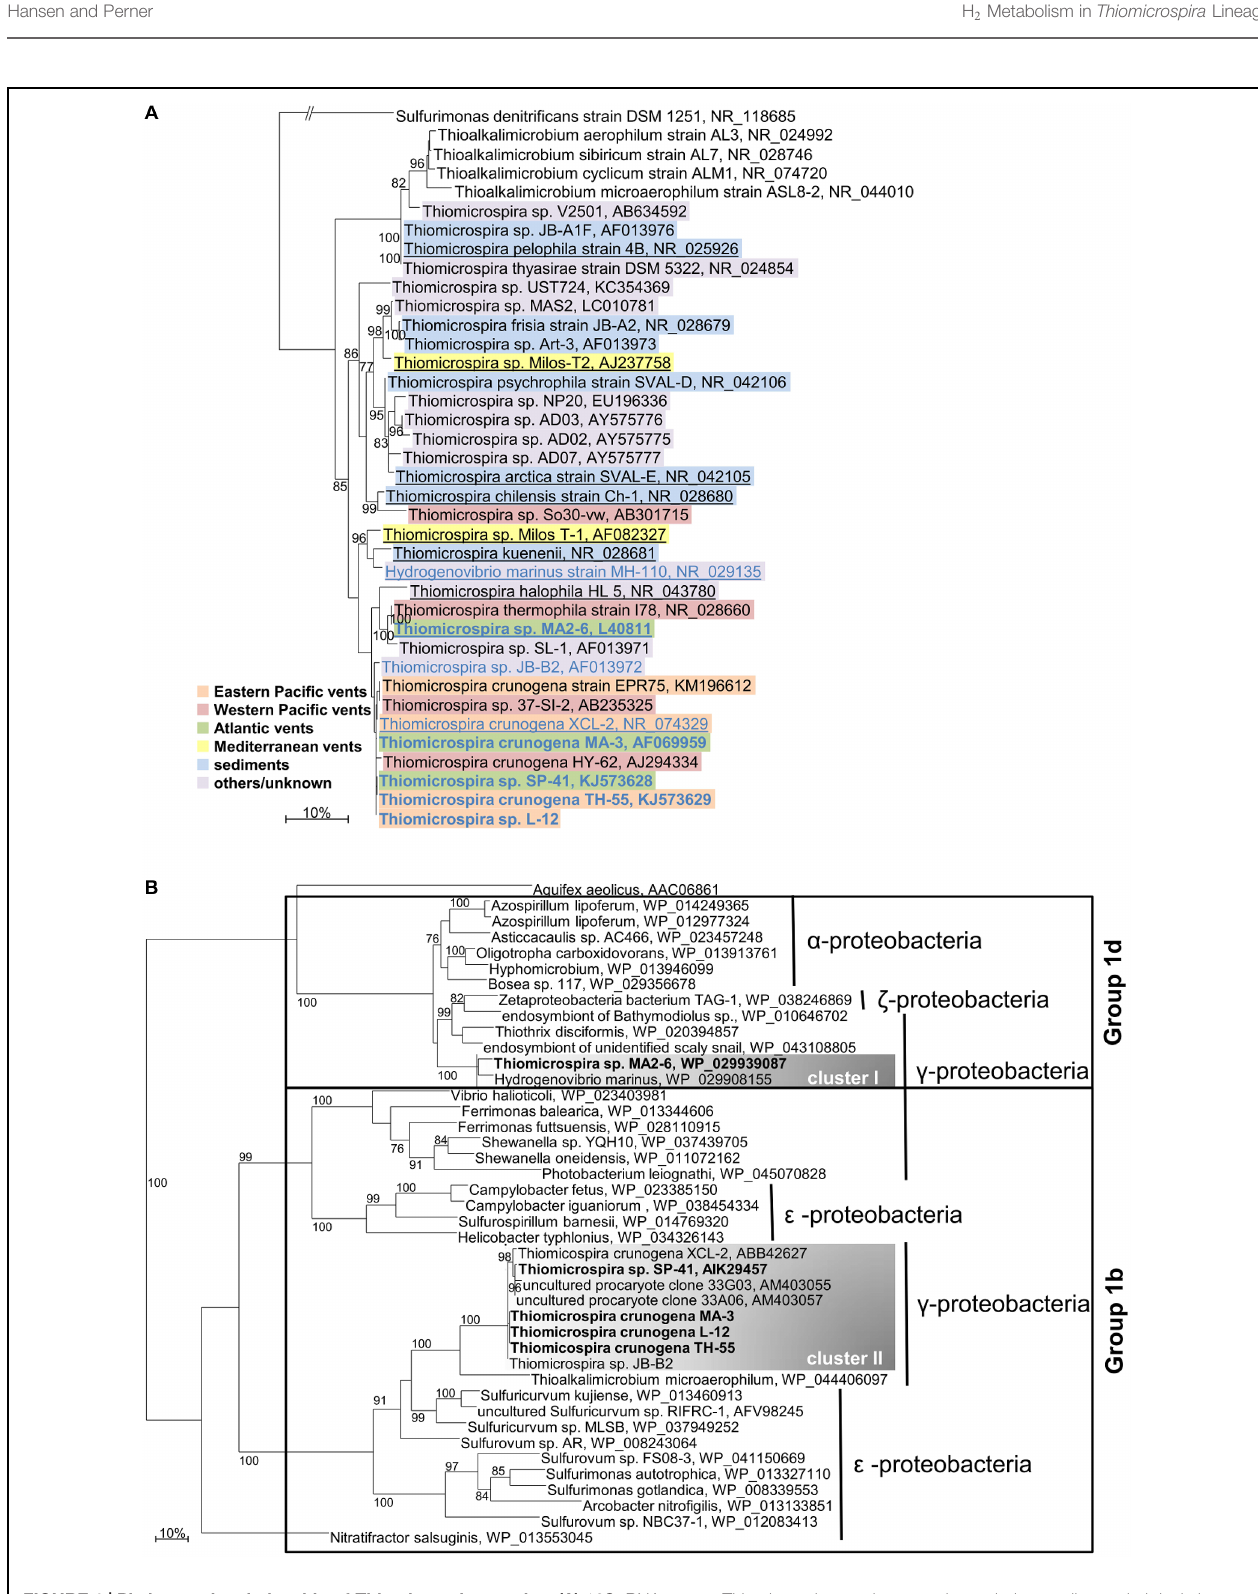
Frontiers in Microbiology |